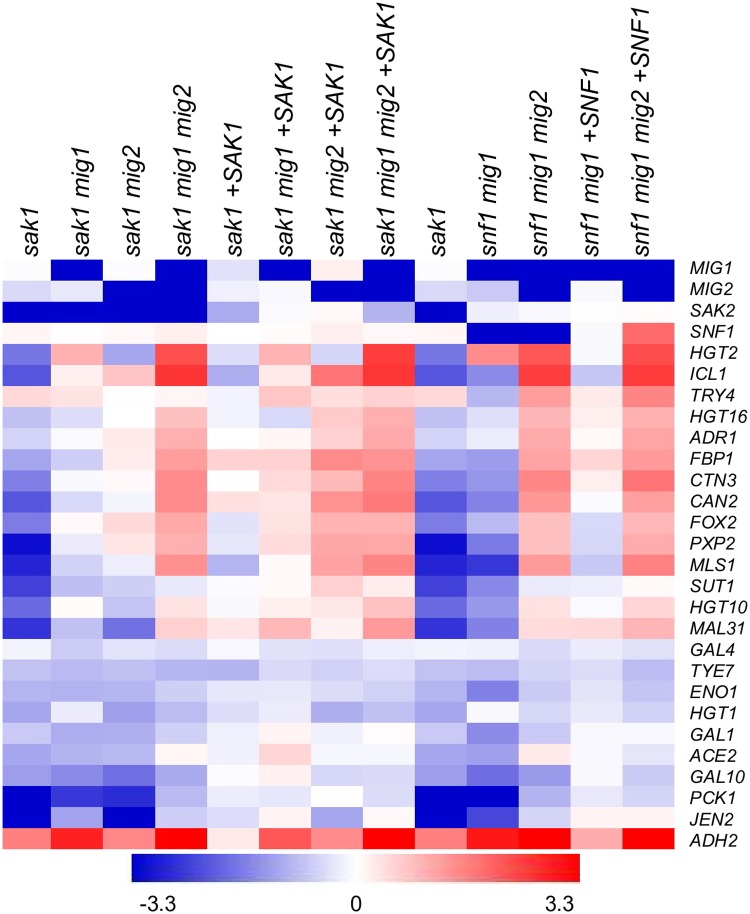
Epistasis analysis among mutations in MIG1, MIG2, SAK1, and SNF1.Heatmap of log2-fold changes in gene expression of selected carbon metabolism genes analyzed using Nanostring. RNA was extracted from strains CW542 (wild type), KL988(sak1Δ/Δ), KL951(sak1Δ/Δ mig1Δ/Δ), KL960(sak1Δ/Δ mig2Δ/Δ), KL955(sak1Δ/Δ mig1Δ/Δ mig2Δ/Δ), KL992(sak1Δ/Δ +SAK1), KL972(sak1Δ/Δ mig1Δ/Δ +SAK1), KL990(sak1Δ/Δ mig2Δ/Δ +SAK1), KL974(sak1Δ/Δ mig1Δ/Δ mig2Δ/Δ +SAK1), and KL953 (snf1Δ/Δ mig1Δ/Δ), KL957(snf1Δ/Δ mig1Δ/Δ mig2Δ/Δ), KL970 (snf1Δ/Δ mig1Δ/Δ +SNF1), and KL976(snf1Δ/Δ mig1Δ/Δ mig2Δ/Δ +SNF1) grown in triplicate in YPG medium at 37°C. Fold change values were calculated by dividing expression of each gene to the wild type. The sak1Δ/Δ mutant strain analysis is duplicated for ease of comparison to the snf1Δ/Δ mutant strains because a snf1Δ/Δ mutant strain is not viable.